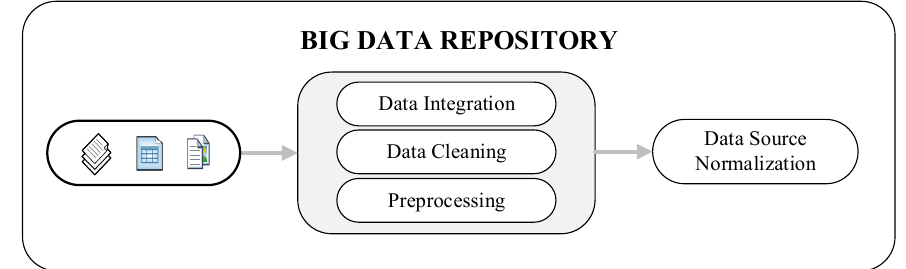
Figure 1. Integration of data from heterogeneous sources.